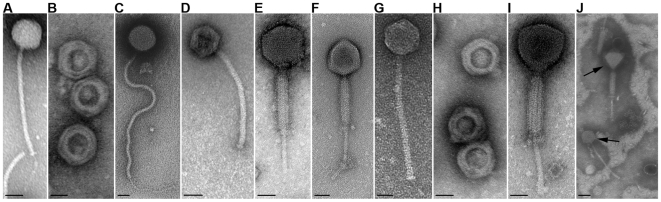
Transmission electron micrographs of bacteriophages negatively stained with 2% uranyl acetate.The bacteriophages infecting B. anthracis include, (A) Wβ, (B) Wip1, (C) Wip2, (D) Wip4, (E) Wip5, (F) Frp1, (G) Frp2, (H) Htp1, and (I) Bcp1. An extract from the gut of the earthworm Eisenia fetida is shown (J) with two distinct and uncharacterized phages indicated by arrows. Scale bars represent either 25 nm (A–I) or 50 nm (J).